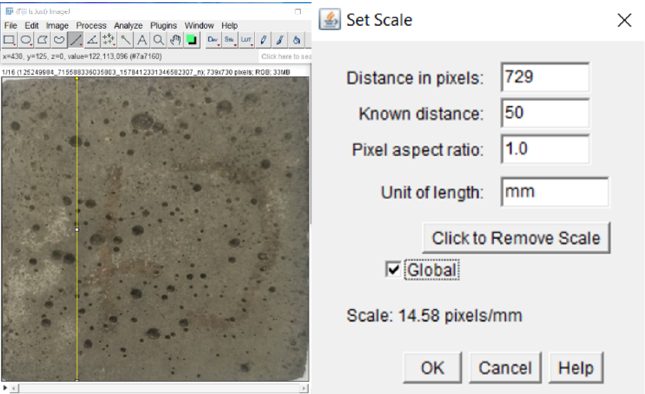
Figure 4. Original and modified images.